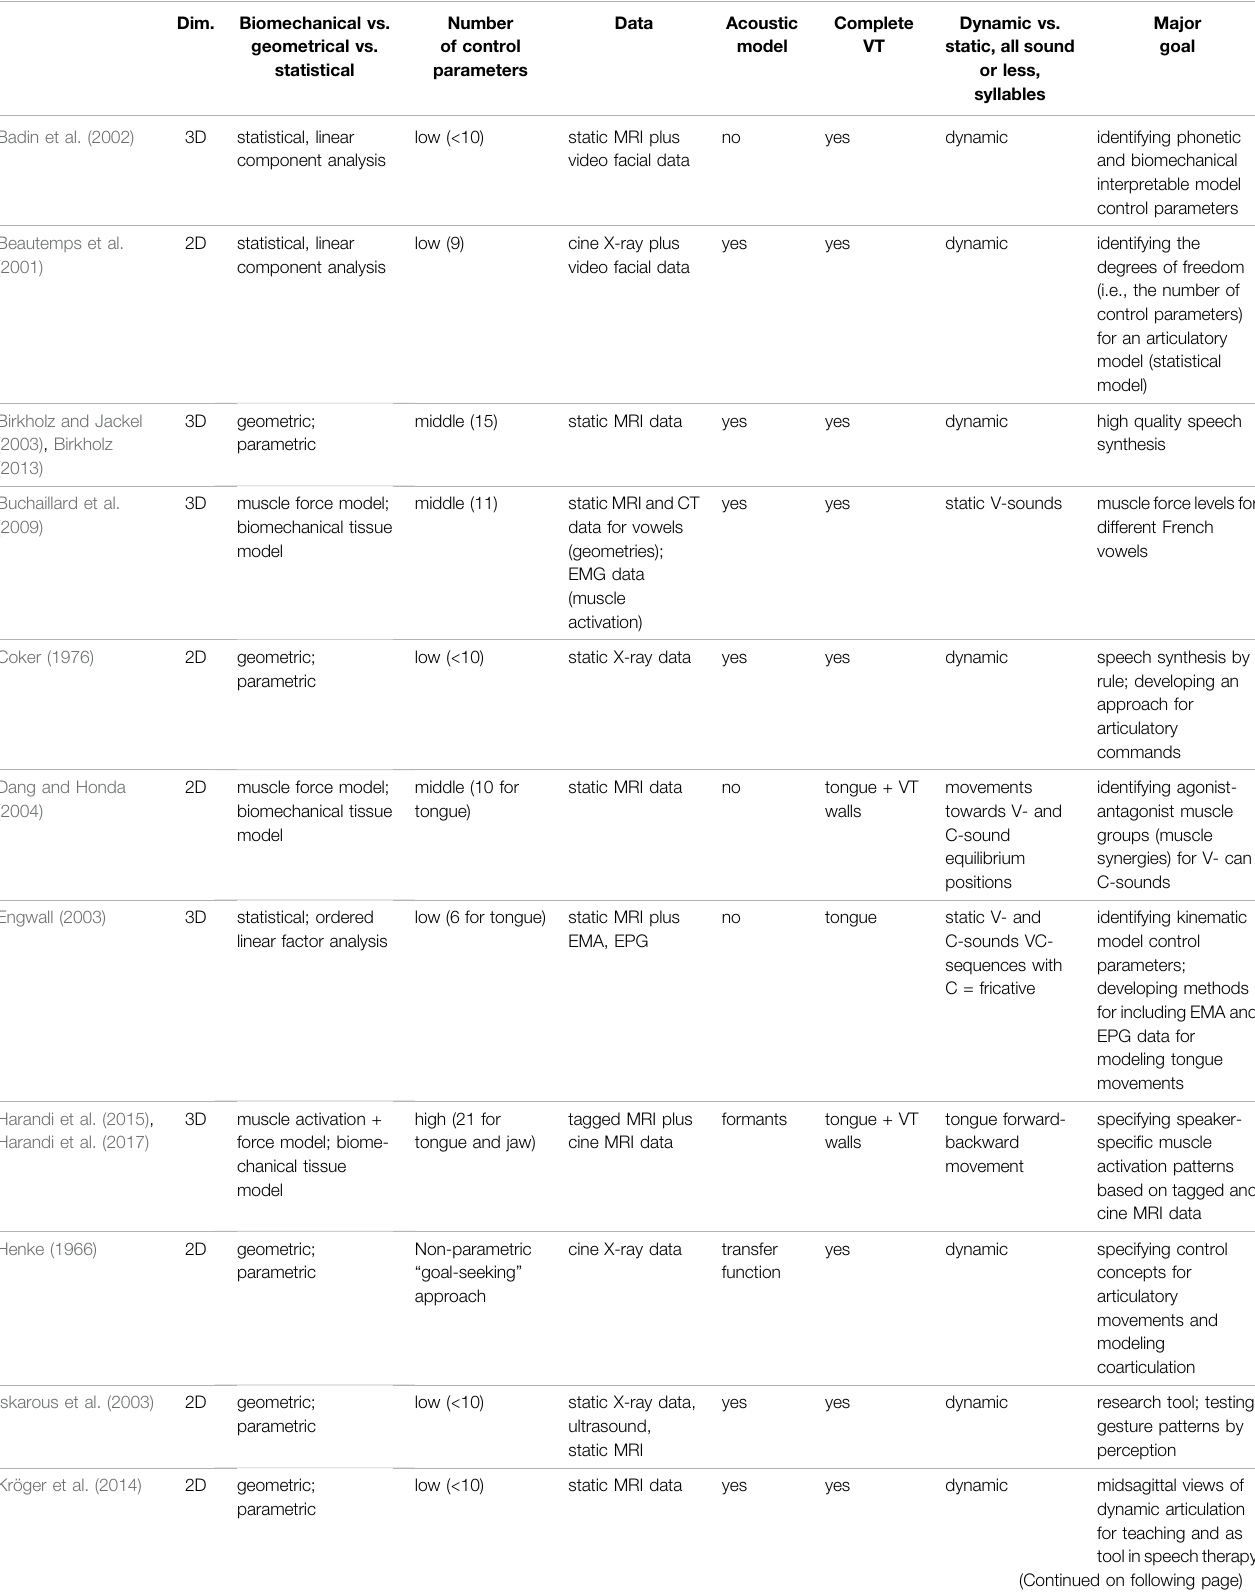
TABLE 1 | List of computer-implemented articulatory models (rows) and criteria for differentiating articulatory models with respect to several features (rows; see